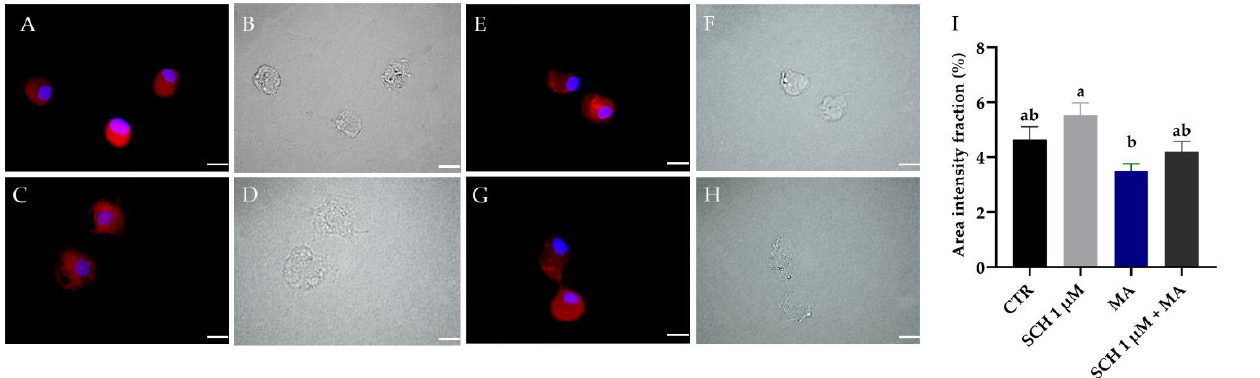
Figure 4. Detection of dopamine in the hemocytes of Rhipicephalus microplus tick females 24 h after inoculation of dopamine receptor antagonist. ( A , C , E , G ) Immunofluorescence images and ( B , D , F , H ) light microscopy images. ( A , B ) untreated ticks (CTR); ( C , D ) ticks inoculated with antagonist (SCH 1 µM); ( E , F ) ticks inoculated with Metarhizium anisopliae (MA); ( G , H ) ticks inoculated with antagonist followed by M. anisopliae (SCH 1 µM + MA). The scale bar represents 10 µ m. ( I ) Average fluorescence intensity (marked area) percentage and standard error of dopamine in the hemocytes of R. microplus tick females. Bars with the same letter did not differ statistically according to one-way ANOVA and the Tukey ’s test ( p < 0.05).